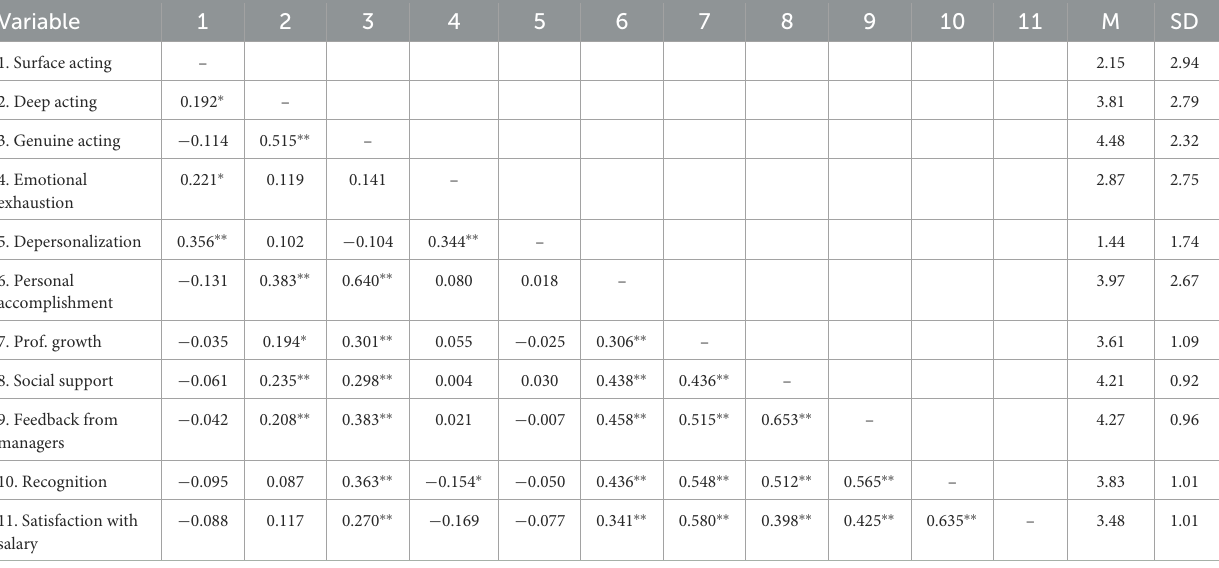
TABLE 3 Correlations, means, and standard deviations of main variables.